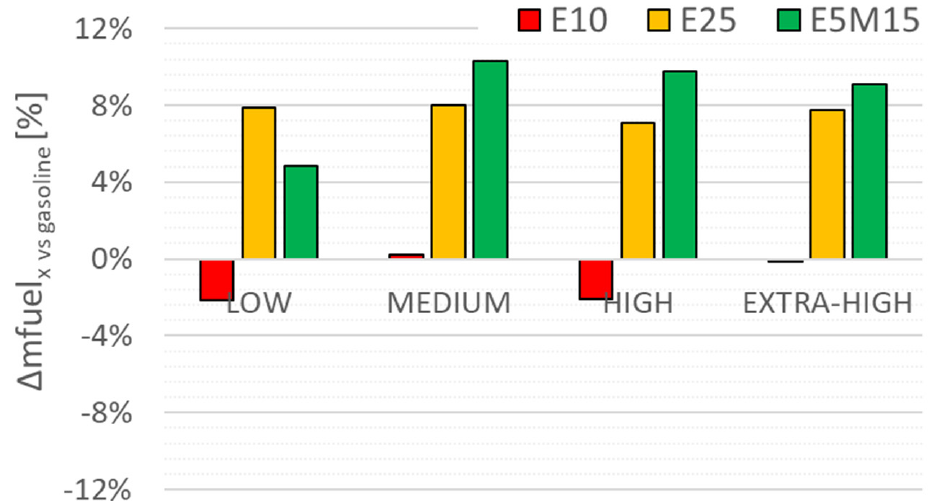
Figure 4. Fuel consumption variation for E10, E25 and E5M15 with respect to gasoline at each phase of the cycle.